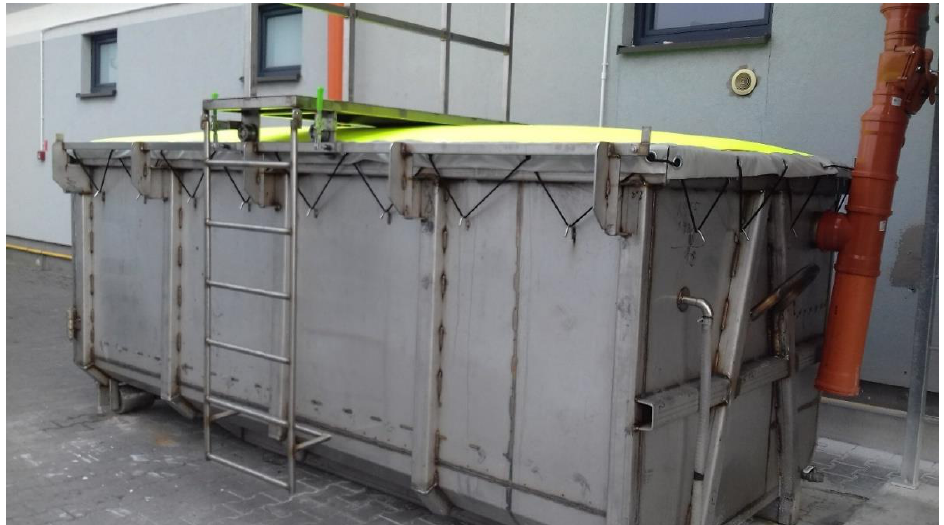
Figure 2. A pilot-scale combined biofilter examined for the treatment of waste gases from a food industry plant located in eastern Poland.